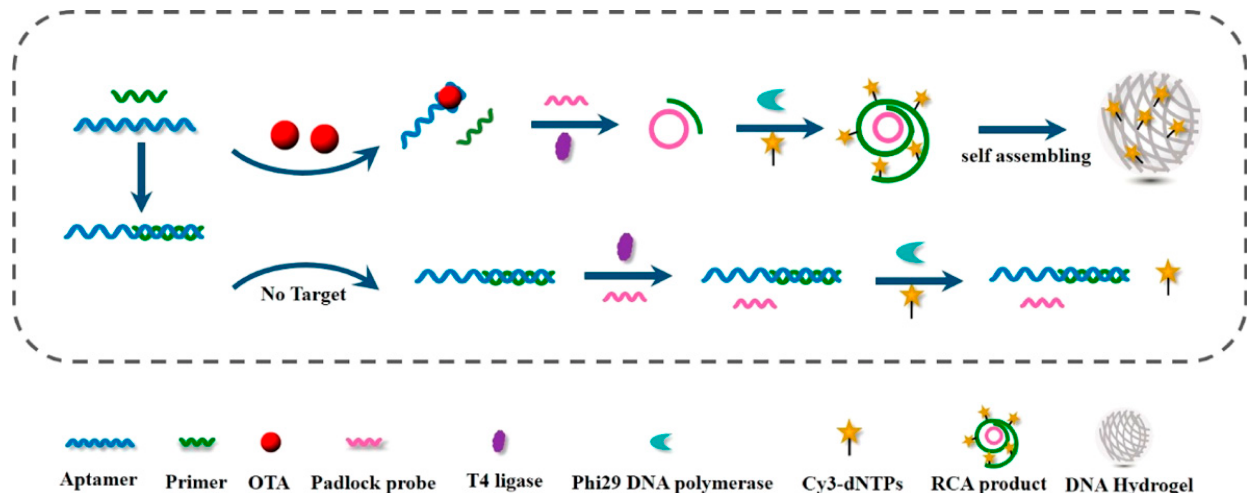
Figure 4. Schematic illustration of fluorescent DNA hydrogels biosensor based on self-assembly of RCA productions for the detection of OTA. Reproduced with permission from Liling Hao, Journal of Agricultural and Food Chemistry; published by American Chemical Society, 2020.